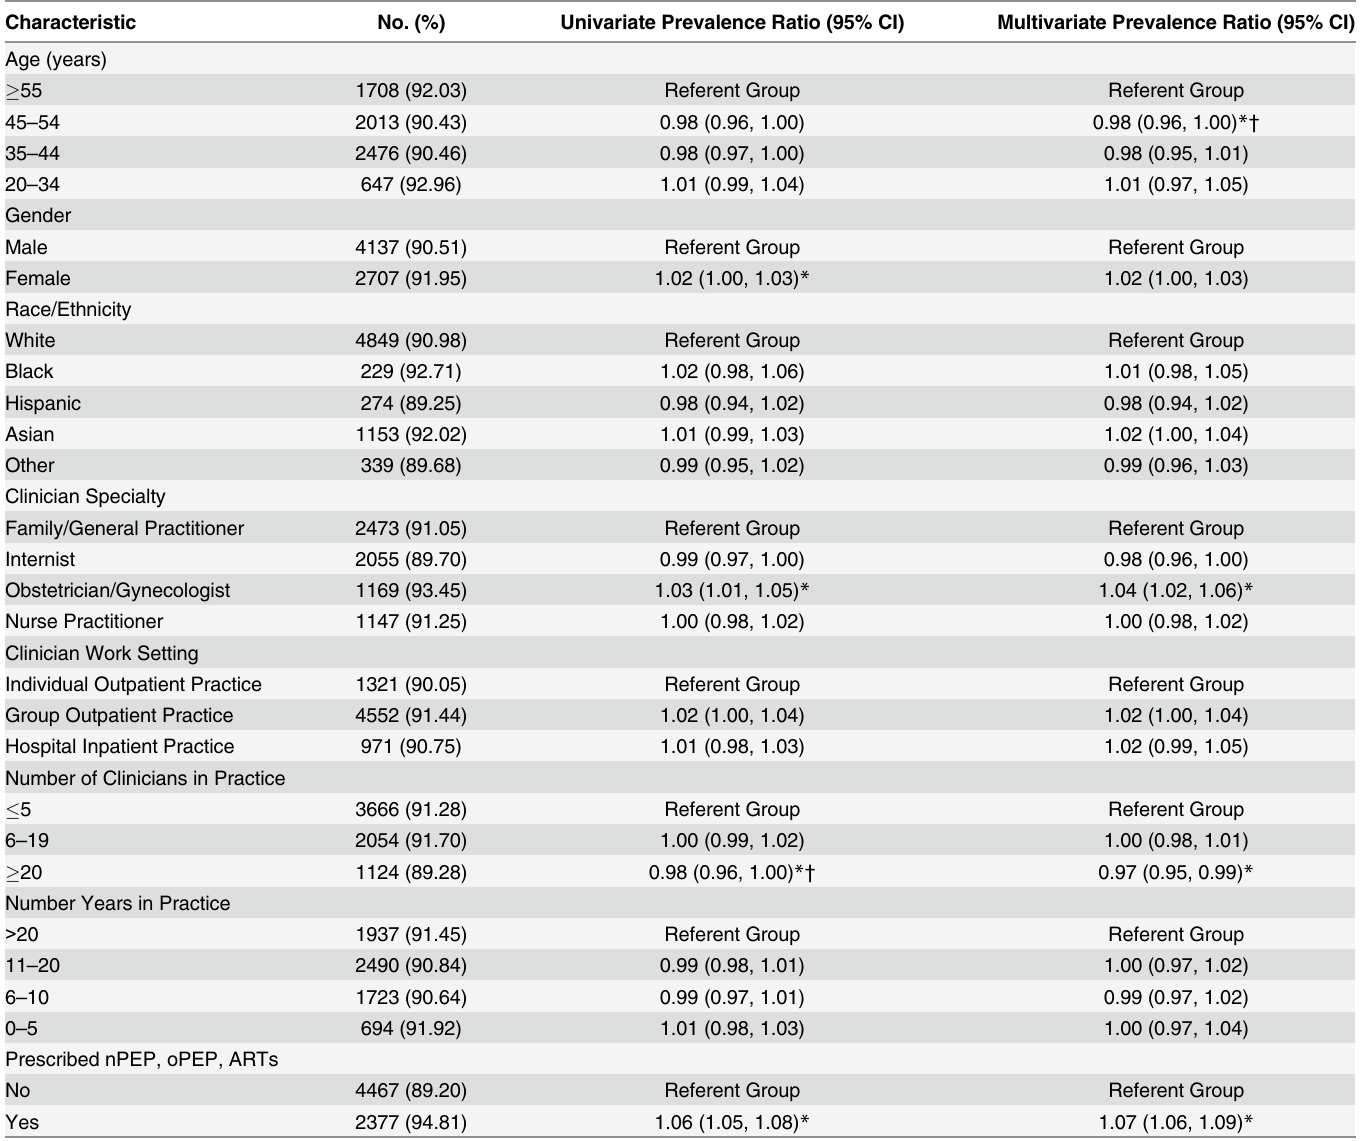
Table 3. Association of Clinician Characteristics with Willingness to Prescribe PrEP: DocStyles 2009 – 2015, United States.